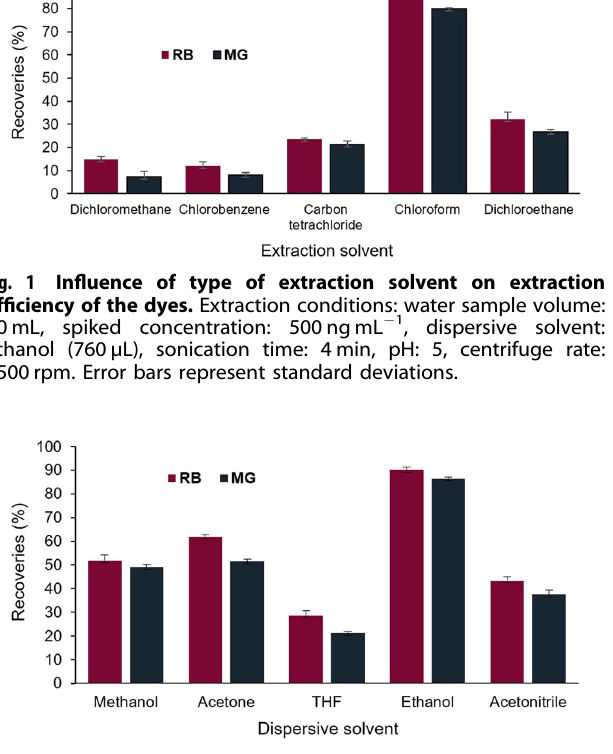
Fig. 2 In fl uence of type of dispersive solvent on extraction ef fi ciency of the dyes. Extraction conditions: water sample volume: 10 mL, spiked concentration: 500 ng mL − 1 , extraction solvent: chloroform (120 µL), sonication time: 4 min, pH: 5, centrifuge rate: 3500 rpm. Error bars represent standard